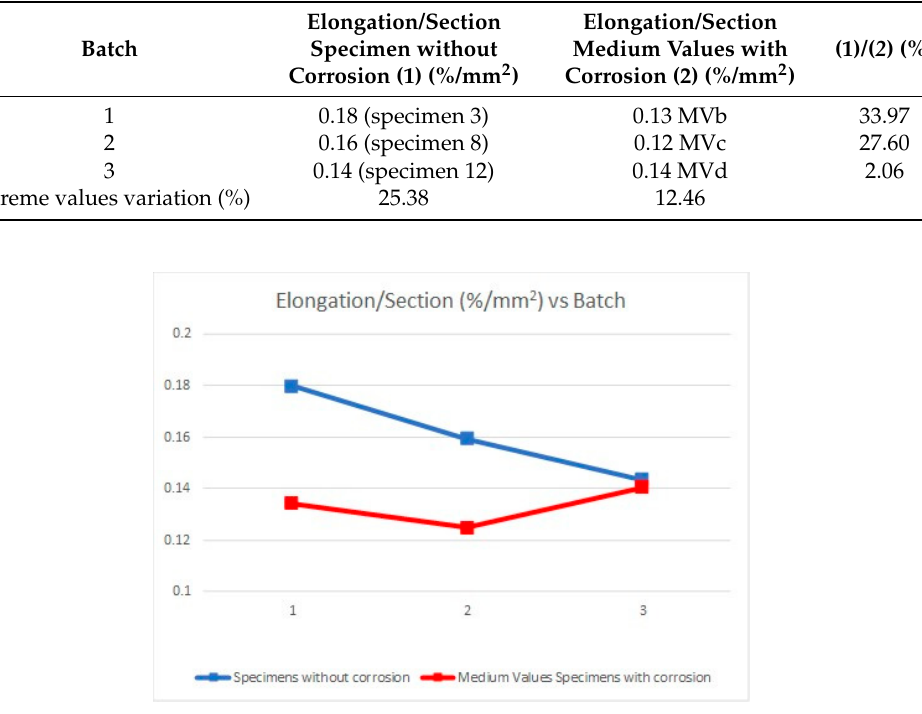
Figure 11. Tensile strength/Section vs. Batch. Table 10. Elongation/Section values per specimen and Medium values vs. Batch.